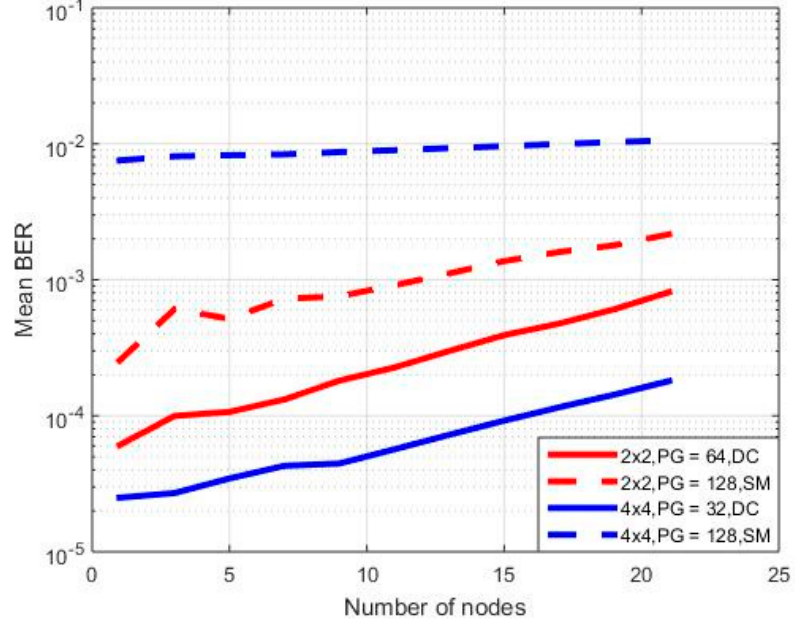
Figure 7. Mean bit error rate (BER) for various MIMO orientations—diversity combining and spatial multiplexing.